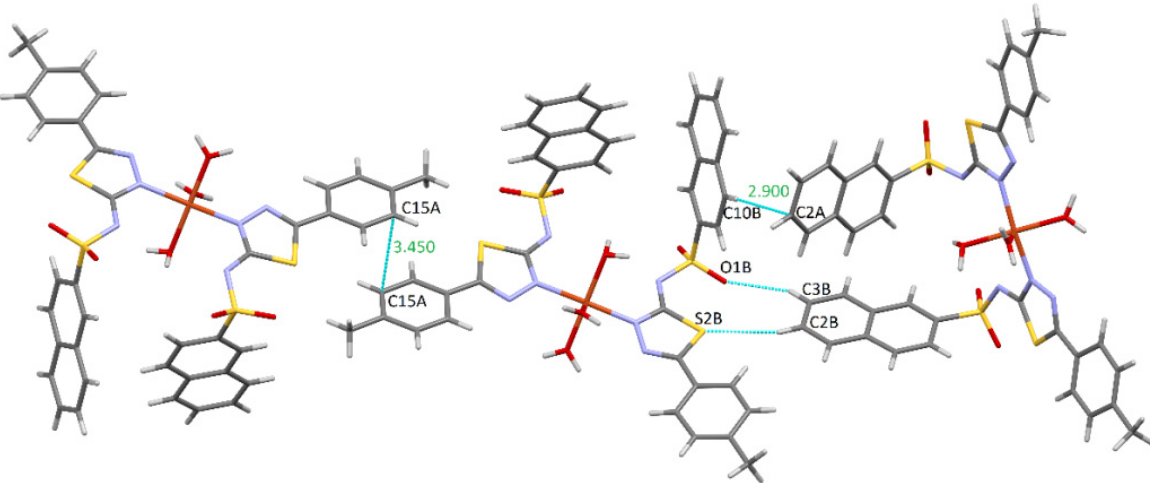
Figure 4. π∙∙∙π , C ‐ H ∙∙∙π , and other weak van der Waals interactions in complex C1 .